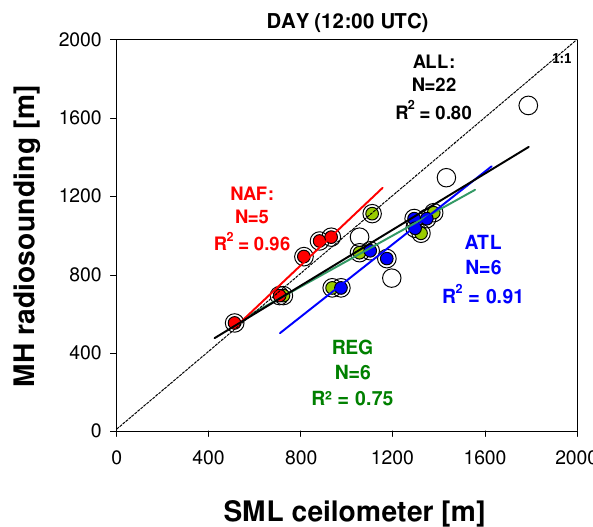
Fig. 4. Correlation between SML heights retrieved from ceilometer Figure 4 and radiosoundings at 12:00UTC for the whole SAPUSS campaign (open circles) and separately for the Regional (REG ; green circles), African (NAF; red circles), and Atlantic (ATL; blue circles) sce- narios. N : number of aerosol backscatter and potential temperature vertical profile pairs; R 2 : coefficient of